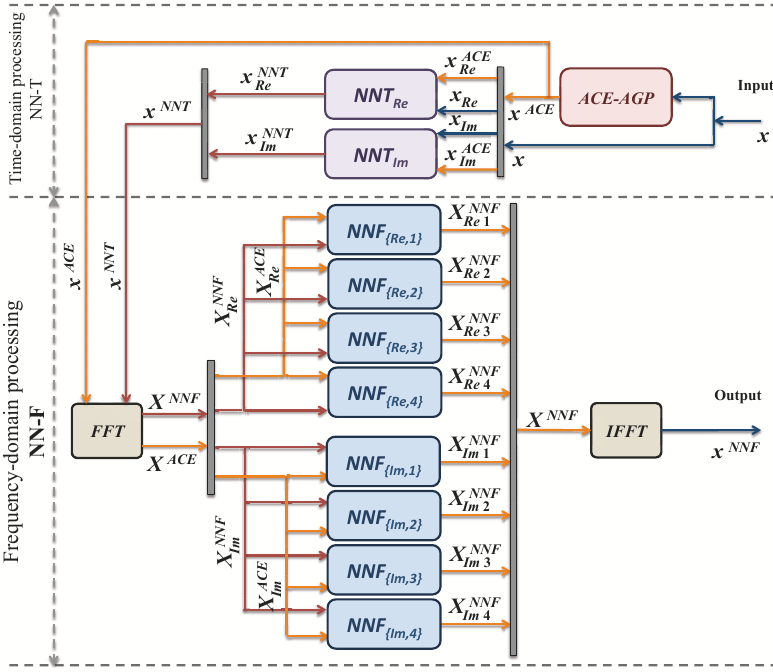
Figure 4. Time-domain and frequency-domain Neural Network training.